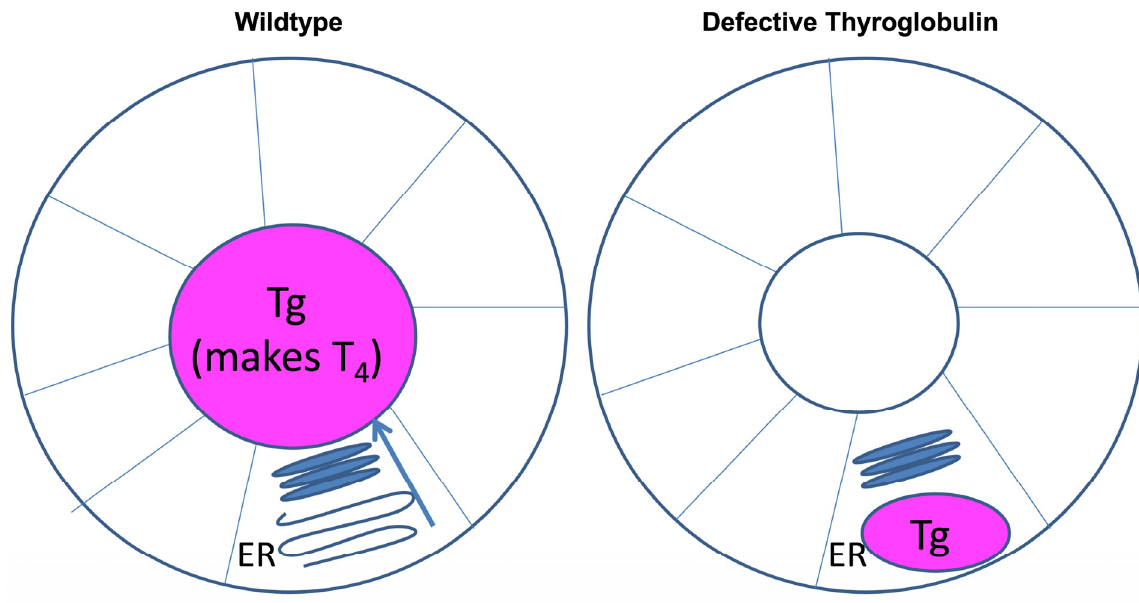
Figure 2. The distribution of thyroglobulin protein in thyroid follicles under conditions that are either wildtype ( left ), or in case of Hypothyroidism with Defective Thyroglobulin ( right ). In wildtype thyroid ( left ), Tg is synthesized in the ER of within the thyroid epithelial monolayer. From there, Tg undergoes intracellular trafficking leading to its secretion into the follicular lumen. Secreted Tg serves as the primary substrate of thyroid hormone biosynthesis, utilizing thyroidal iodination machinery that is located at the apical membrane. In hypothyroidism with defective Tg ( right ), misfolded Tg is blocked in intracellular transport from the ER, inducing ER stress with massive ER expansion. Tg remaining within the ER of the thyroid epithelial monolayer is unavailable for thyroid hormone biosynthesis.